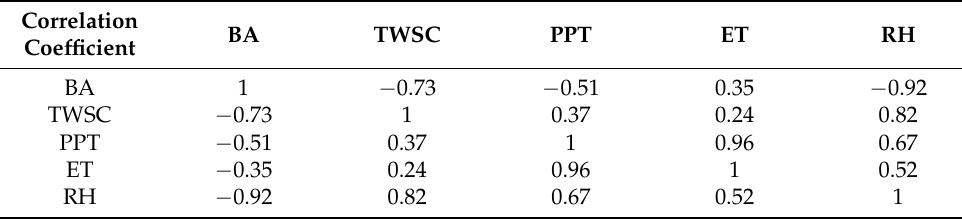
Table 4. The correlation coefficients between burned area (BA), PPT, ET, relative humidity (RH) and TWSC on the seasonal scale in region